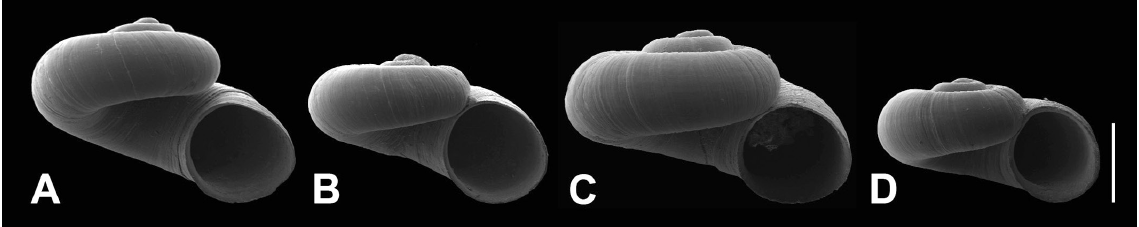
Fig. 13. Paratypes from type localities (SEM micrographs). A–B . H. lozekiana sp. nov.